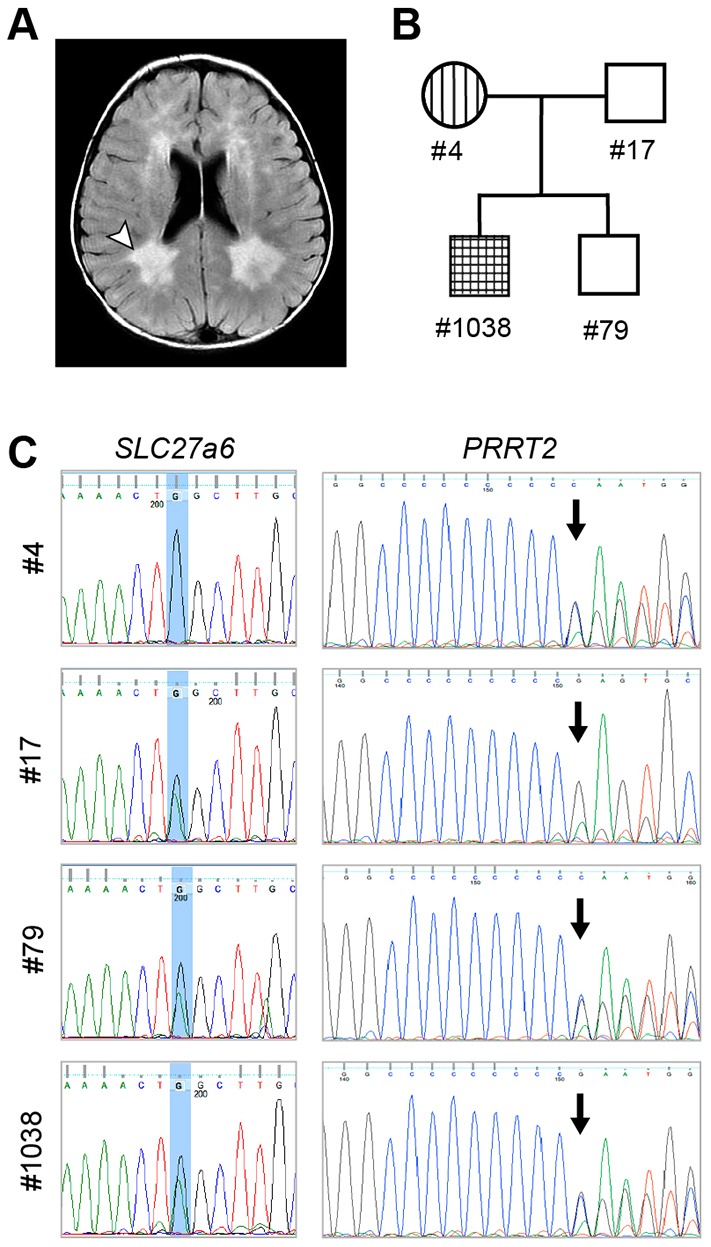
Identification of a leukodystrophy patient with mutations in SLC27a6. (A) MRI scan of an 18-month-old boy presenting with epilepsy. Arrowhead points to one of the expanded lateral ventricles, diagnostic of leukodystrophy; the paired structural defect is evident on the right side as well. (B) Pedigree shows family-member phenotypes: PRRT2-dependent benign familial infantile epilepsy (vertical hatching); leukodystrophy (horizontal hatching). The proband is designated as #1038. (C) Sequence data for SLC27a6 and PRRT2, respectively. Carriers of the SLC27a6 mutant allele have a C>T transition; the resultant nonsense mutation leads to premature termination of the protein. Carriers of the PRRT2 mutant allele have a C duplication at position 649; this frameshift leads to premature termination of the protein.